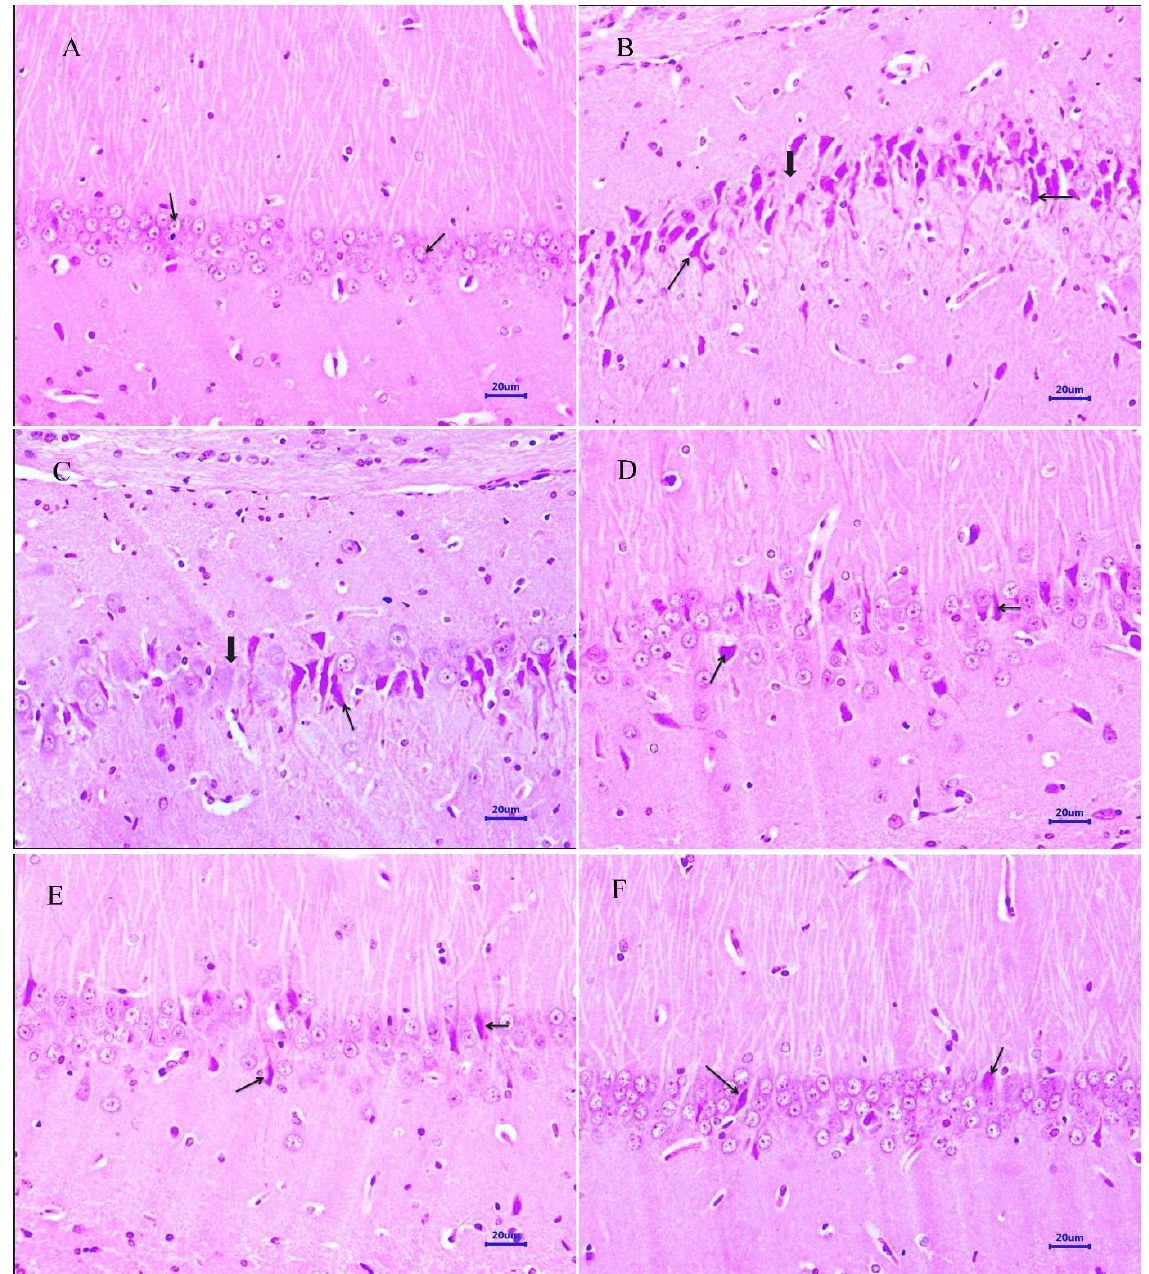
Figure 8. Effect of quercetin and quercetin administered with memantine on H&E-stained hippo- campus tissue (400×). ( A ): Normal control, ( B ): Disease control, ( C ): Memantine (20 mg/kg), ( D ): Quercetin (50 mg/kg), ( E ): Memantine + quercetin (20 + 25 mg/kg), ( F ): Memantine + quercetin (20 + 50 mg/kg).